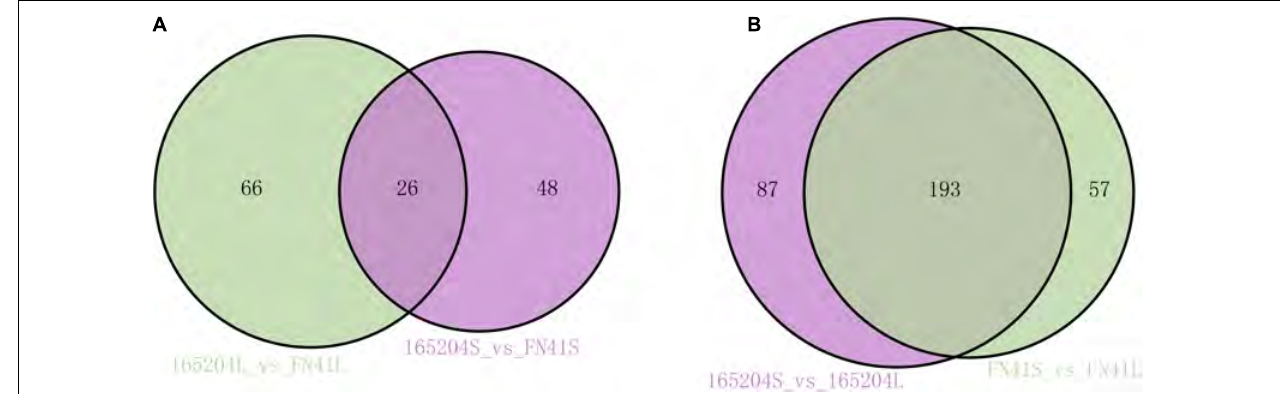
FIGURE 4 | Kyoto Encyclopedia of Genes and Genomes enrichment analysis of the DEMs between (A) 165204S_vs_FN41S, (B) FN41S_vs_FN41L, (C) 165204L_vs_FN41L, and (D) 165204S_vs_165204L.